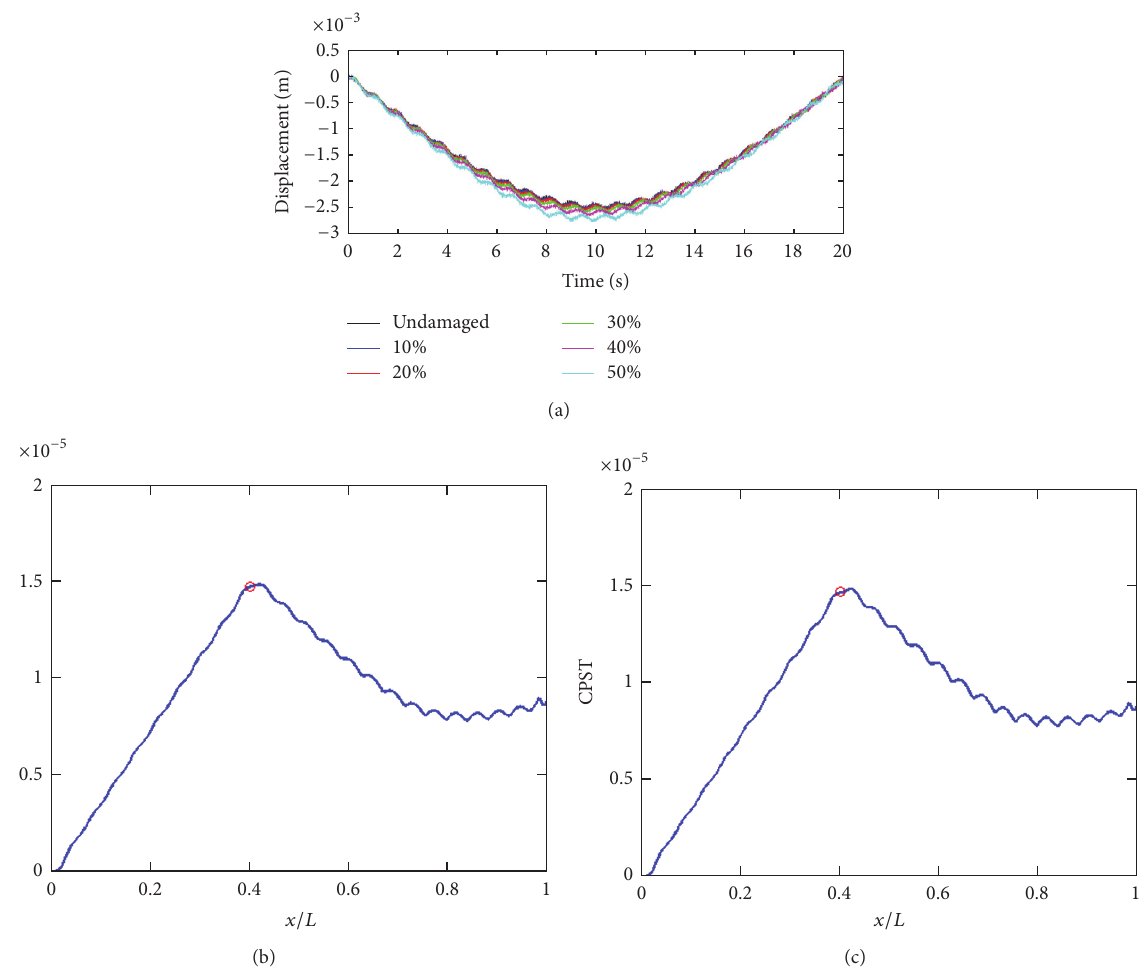
Figure 28: Results using noise contaminated displacement responses with V = 1 m/s, 𝑚 𝑚 = 200 Kg, 𝐿 𝑑 = 0.4 , and 𝐿 𝑠 = 0.5 : (a) 30% noise contaminated displacement responses, (b) CPST for 10% damaged scenario with 10% noise, and (c) CPST curve for 10% damaged scenario with 30%